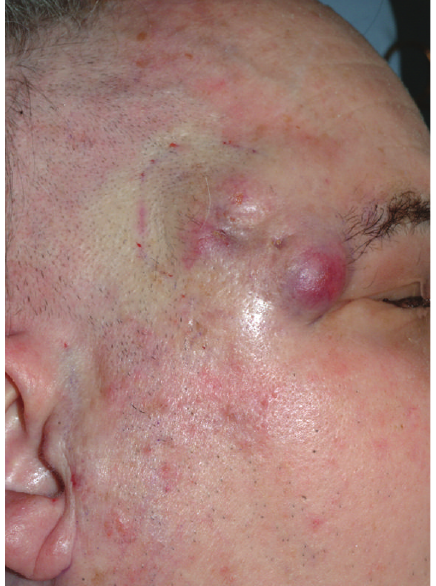
Figure 2: Right-sided Merkel cell carcinoma of the temporal region in a 63-year-old male. The lesion started as a small violaceous nod- ule approximately six months prior to presentation. This was excis- ed locally at an outside institution and subsequently recurred in the region of the previous excision. The lesion subsequently enlarged and resulted in right-sided weakness in the distribution of the frontal branch of the facial nerve. Pain in the region was mild. Subsequent biopsy revealed MCC. Note multinodular cutaneous induration and anterior violaceous appearance, classic for advanced